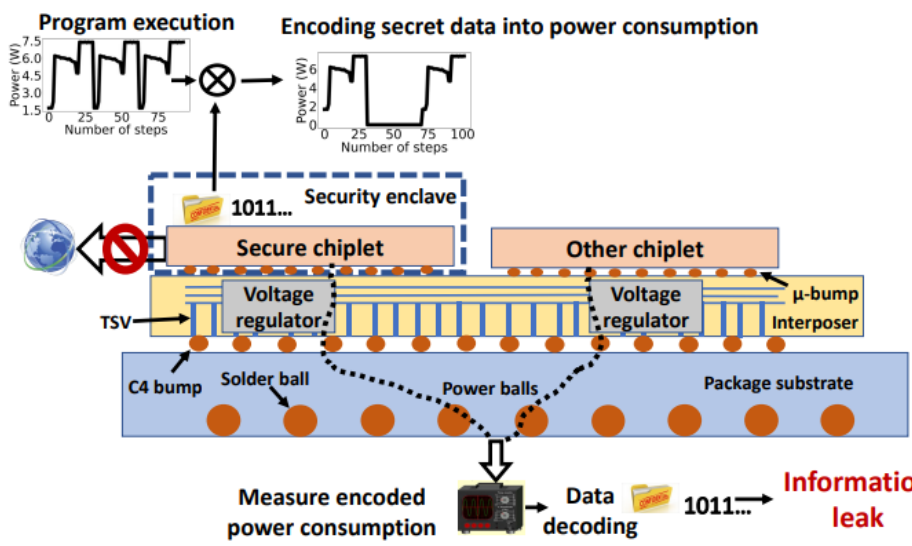
Figure 8. Attack model of a power covert channel between a secure chiplet and